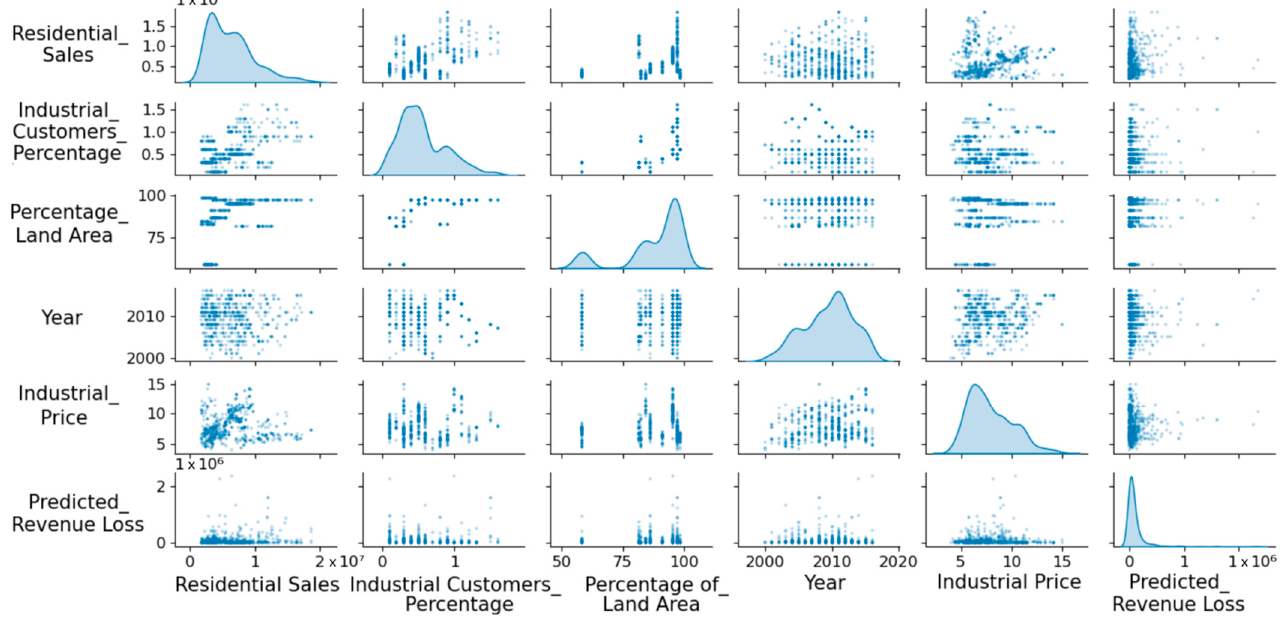
Figure 17. Performance analysis graph of top five important features for revenue loss prediction.